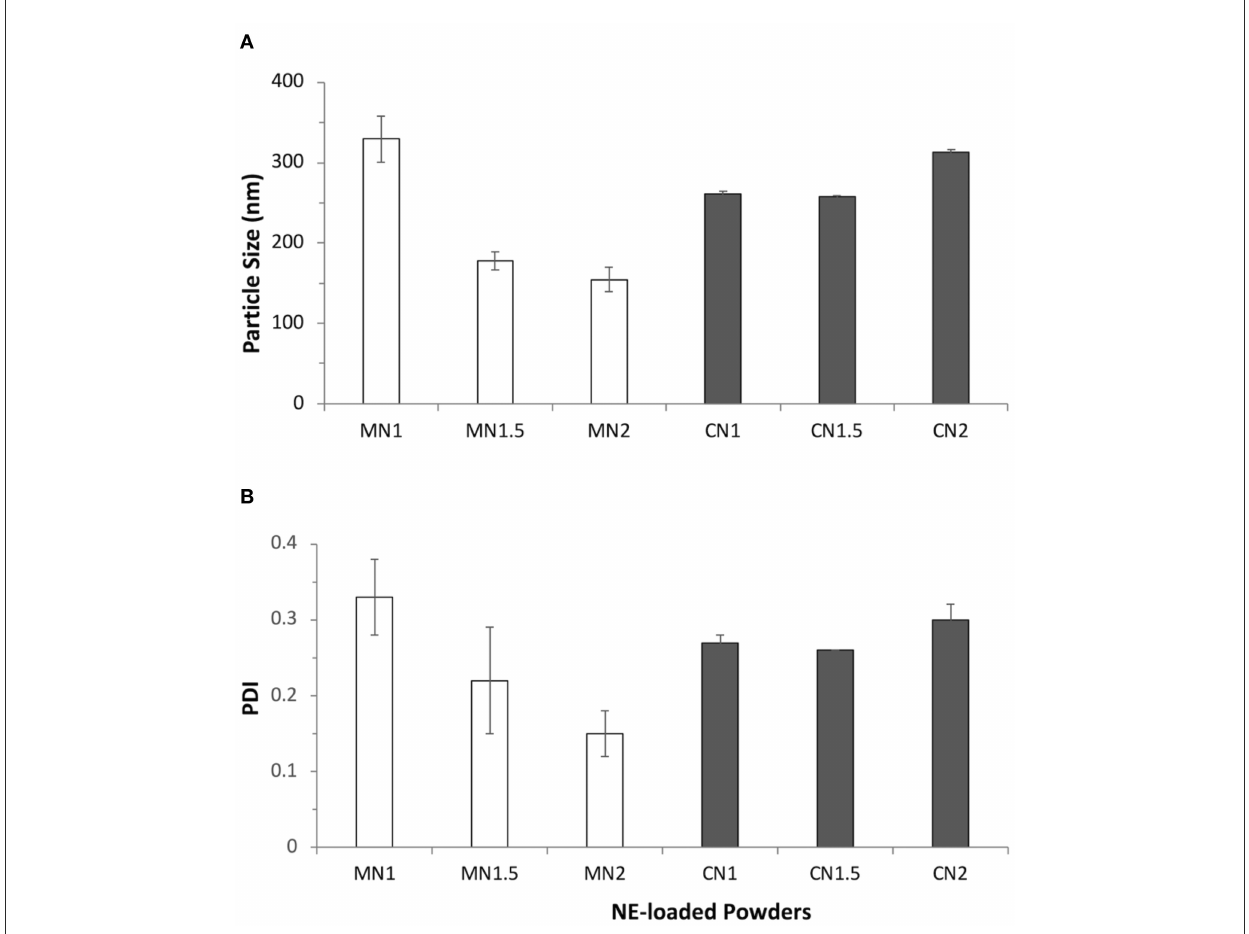
FIGURE3 (A) Average size (nm) and (B) polydispersity index (PDI) of particles obtained after redispersion in water of dry powders obtained by layering nanoemulsions (NE50) on different solid carriers: mannitol (MN1, MN1.5, MN2; white bars) and calcium carbonate (CN1, CN1.5, CN2; gray bars) at different liquid-to-solid weight